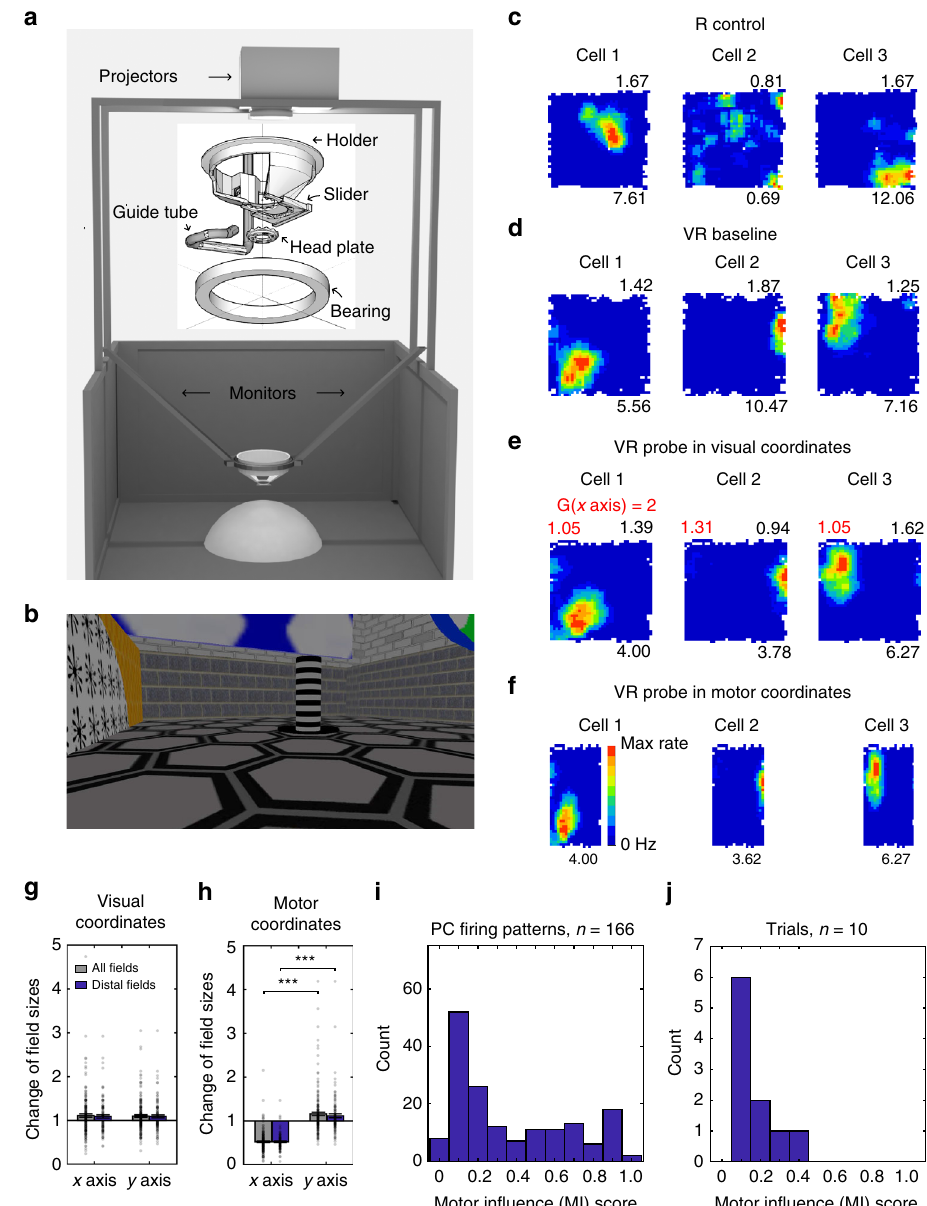
Fig. 1 Place cell fi ring patterns under visual gain increase. a , b Schematic of the VR setup ( a , inset: the rotating head-holder) and view from inside the VR environment, the striped column indicates a visible reward location ( b , see Supplementary Video). Adapted from ref. 21 . c – f Three place cells simultaneously recorded in a 60 × 60 cm square box ( c ), a 60 × 60 cm virtual square environment ( d ), and a probe trial where visual gain was increased along the x axis ( G = 2) plotted in visual coordinates ( e ) and motor coordinates ( f ). Firing rate maps shown with max rate below (Hz) and spatial information above (bits/spike), stretch factor F mapping visual plots to baseline shown in red, all three trials recorded on the same day. g , h Change of place fi eld size (ratio relative to baseline) was signi fi cantly larger on the manipulated than un-manipulated axis when plotted in motor coordinates ( h , n = 173 for all fi elds, paired t -test, t (172) = − 14.35, p < 0.001; n = 112 for fi elds distal to boundaries, t (111) = − 12.22, p < 0.001) but not when plotted in visual coordinates ( g ; n = 173 for all fi elds, t (172) = 0.29, p = 0.77; n = 112 for distal fi elds, t (111) = − 0.03, p = 0.98), re fl ecting strong visual in fl uence. i , j Distribution of motor in fl uence scores ‘ MI ’ based on fi ring rate maps ( i ) or on population vectors ( j ). Note MI = ( F − 1)/( G − 1), so MI = 0 indicates fi ring in visual coordinates (i.e. F = 1 implies no effect of G ≠ 1); MI = 1 indicates motor coordinates (i.e. F = G : visual stretch factor equals visual gain increase, and median = 0.37, IQR = 0.59 in the gain decrease, see median = 0.08, IQR = 0.11; in gain decrease: median = 0.21, Figs. 1i and 2g and S6). IQR = 0.21, see Figs. 1j and 2h and S7). We also analysed the population vector responses of all simultaneously recorded place cells, fi nding the best single offset Grid cell fi ring patterns . Figure 3 shows fi ring patterns for grid and stretch factor for each population (in 18 trials with multiple place and grid cells), again fi nding greater visual than motor cells plotted against visual or motor location under increases in in fl uence on place cell populations (MI score in gain increase: visual gain ( G = 2). Again we restricted analyses to grid patterns